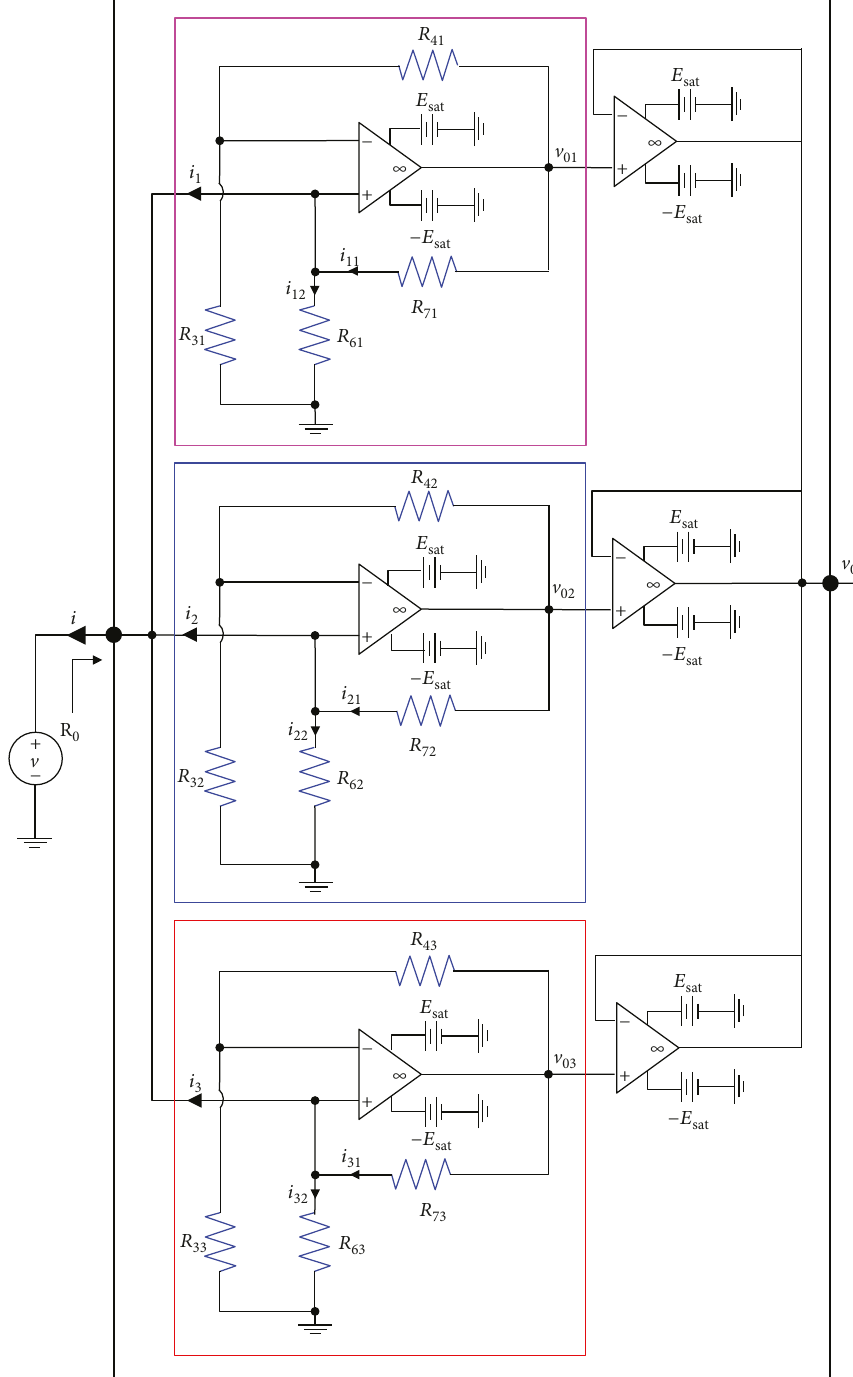
Figure 11: Circuit diagram of nonlinear resistor R